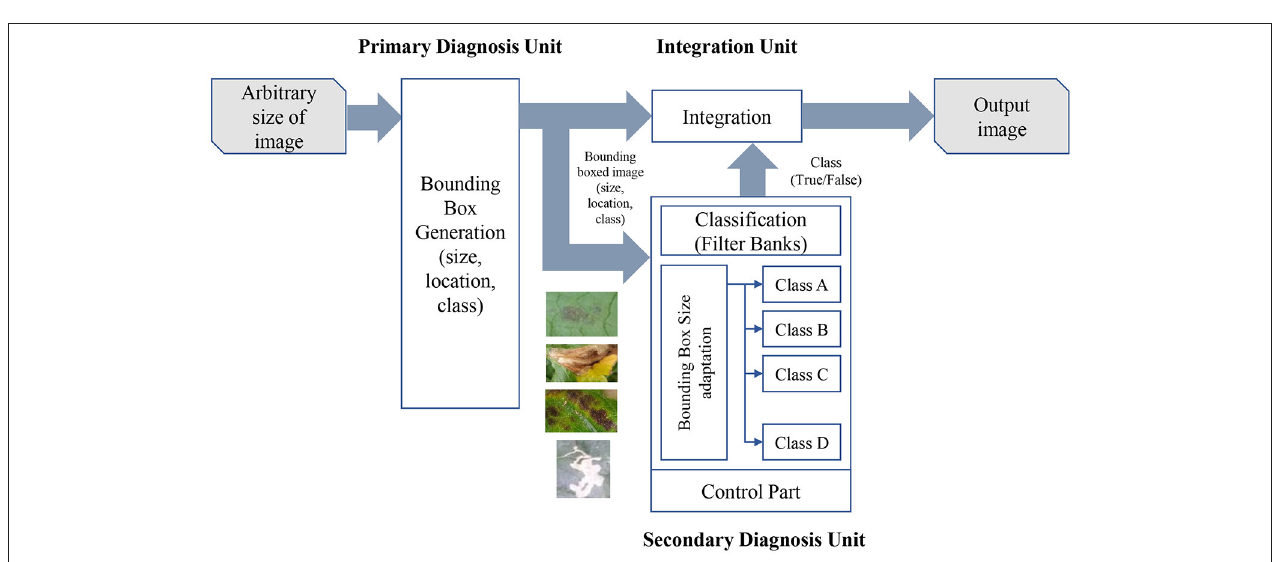
FIGURE 1 | A general overview of our proposed approach. The input images with an arbitrary size are trained in our primary diagnosis unit that generates bounding boxes along with their location and class of the infected areas in the image. The set of bounding boxes is used as input in the secondary diagnosis unit, which independently trains CNN filter banks for each class, with the purpose of reducing the number of false positives generated by the primary unit. Both systems are further integrated into class and location.